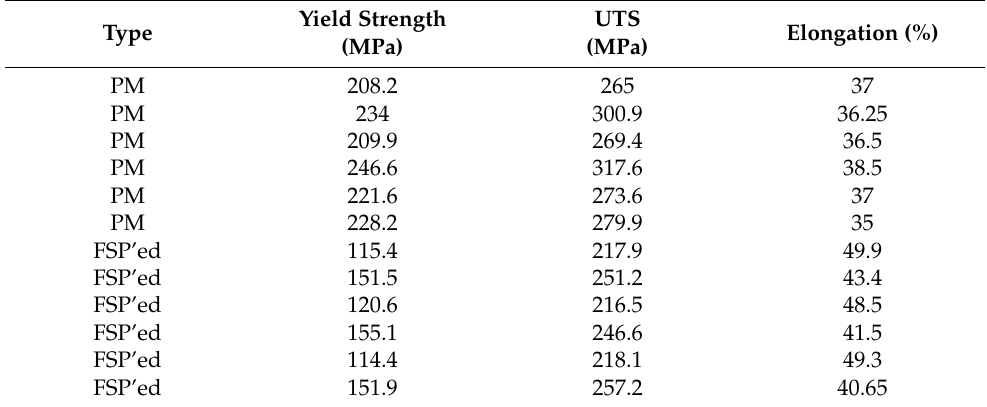
Table 2. Tensile test